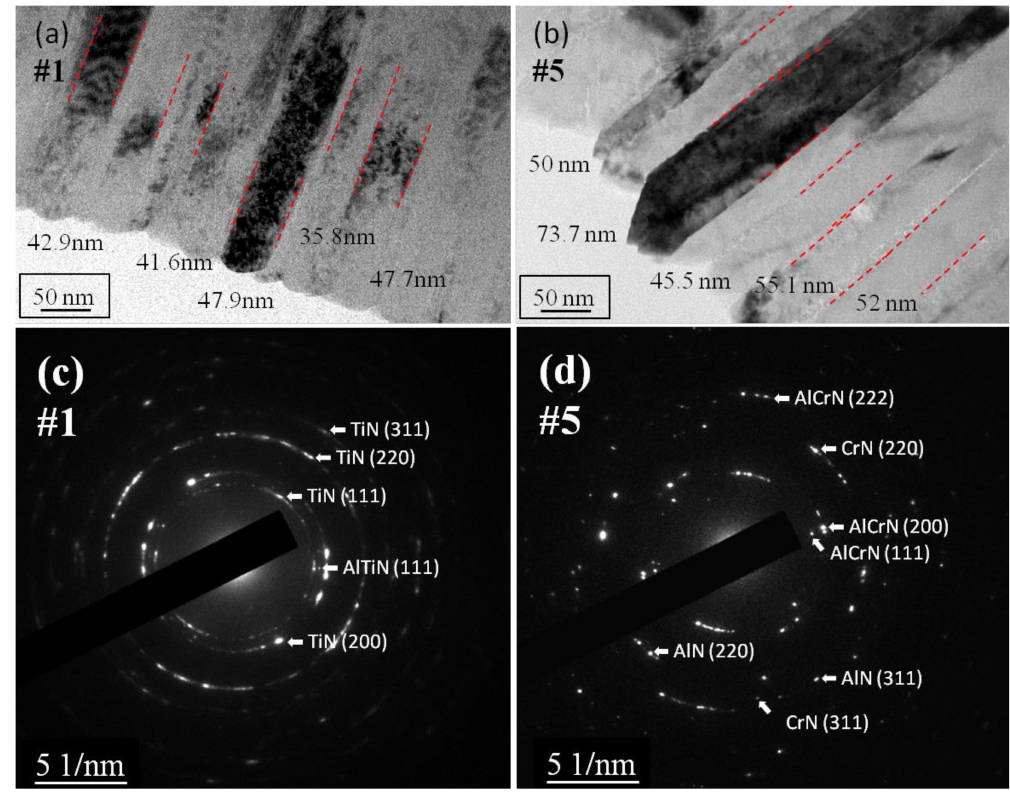
Figure 7. Cross-sectional TEM images of ( a ) #1, ( b ) #5 and SAED patterns of ( c ) #1, and ( d ) #5 coatings fabricated using the input power ratios of the AlCr/Ti target 0.25 and